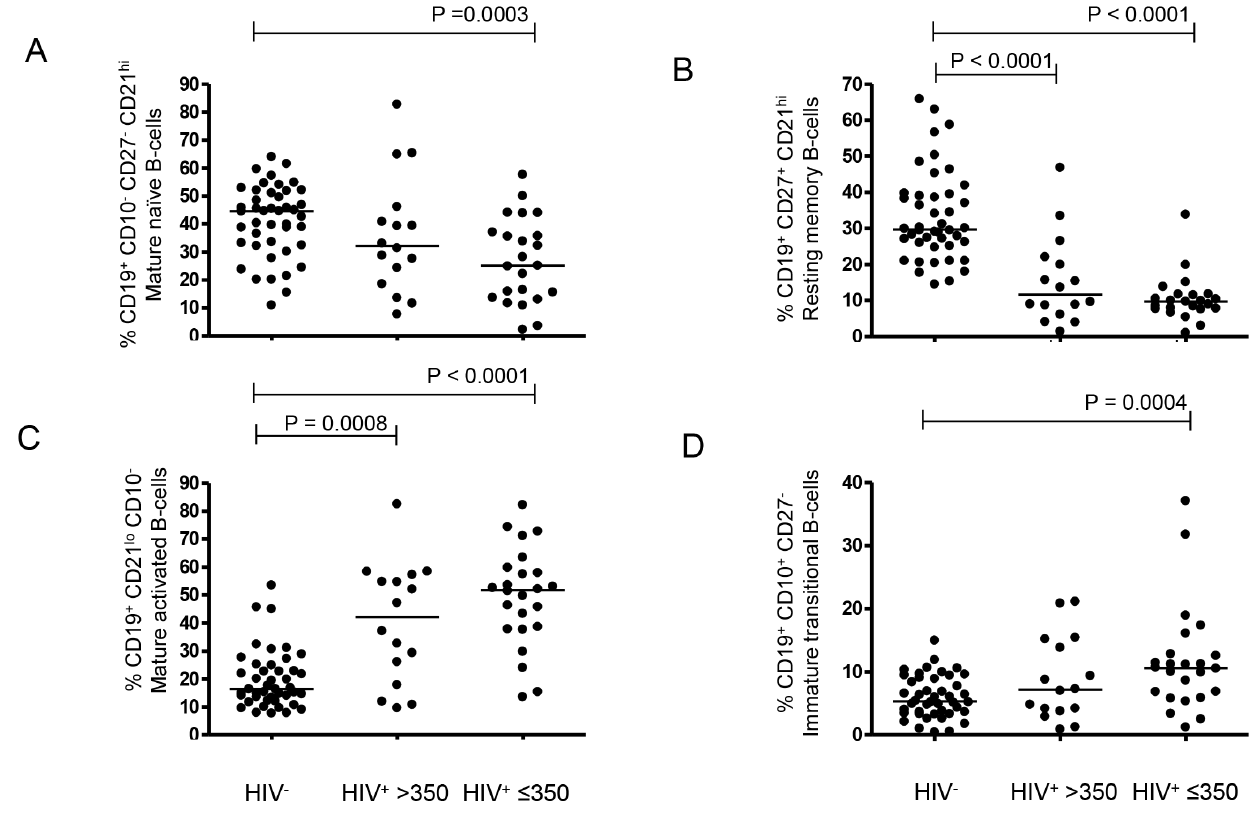
Figure 1. Loss of resting-memory B-cells and overrepresentation of apoptosis-prone mature-activated B-cells occurs early in HIV infection. Percentages of circulating (A) mature naı¨ve (CD19 + CD10 2 CD27 2 CD21 hi ) (B) resting memory (CD19 + CD27 + CD21 hi ) (C) mature activated (CD19 + CD21 lo CD10 2 ) and (D) immature transitional (CD19 + CD10 + CD27 2 ) B-cells measured using flow cytometry in HIV 2 (n=44), HIV + . 350 (n=16) and HIV + # 350 (n=24) adults. Horizontal bars represent median values. Statistical significance of differences between groups was assessed using the Mann Whitney U test.